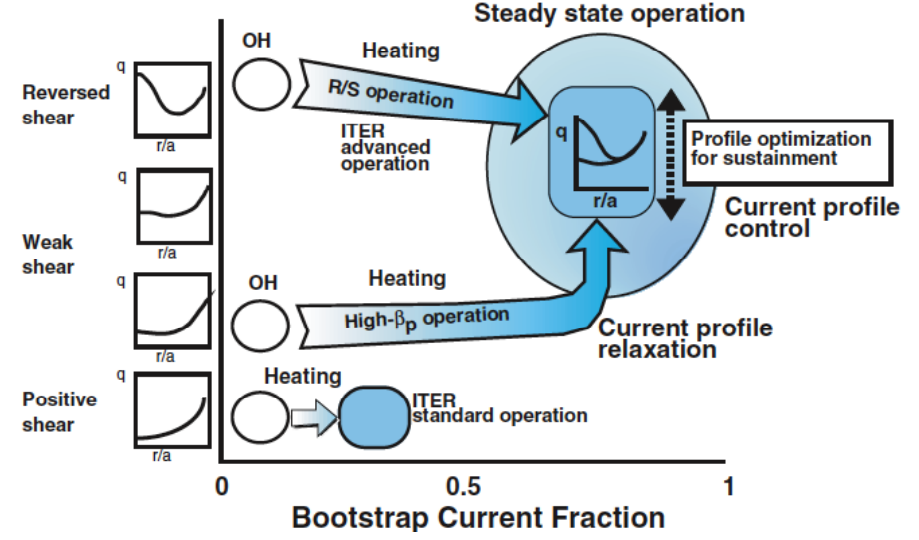
Figure 13. Access to steady state operation regime with high bootstrap current fraction from OH regime. Since current profile is frozen at high temperature, current profile control in the target OH regime is important, according to Kishimoto